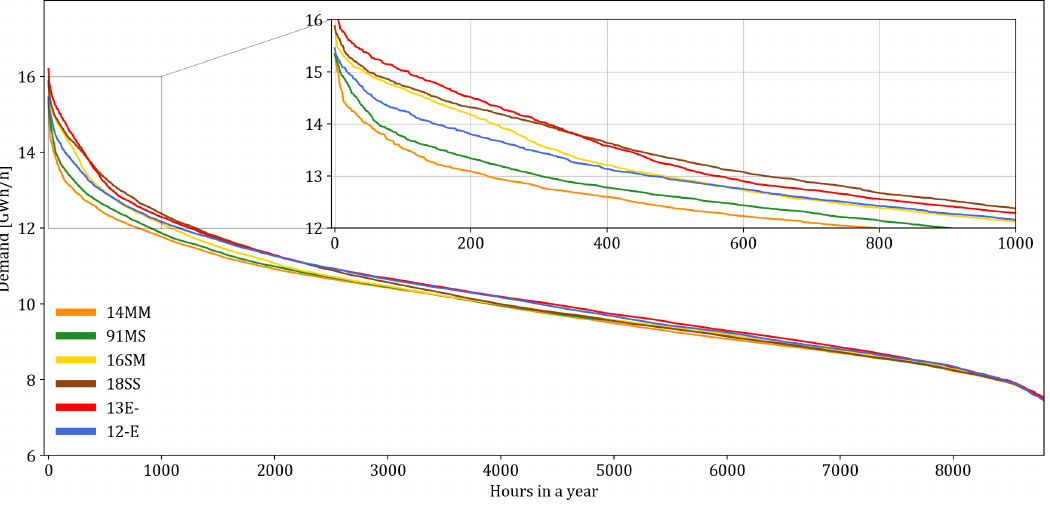
Figure 9. Duration curve of the synthetic demand.